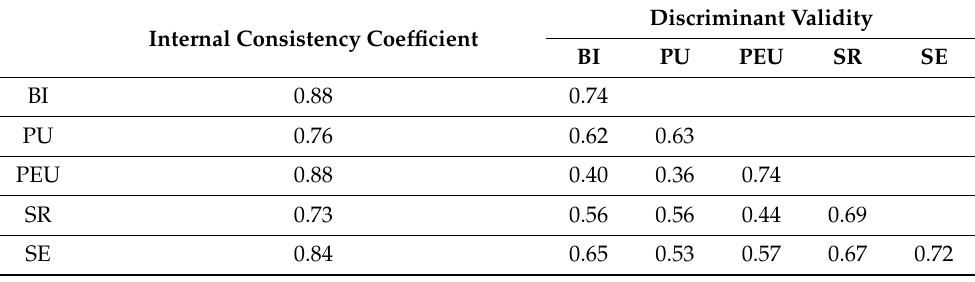
Table 2. Reliability and validity of all